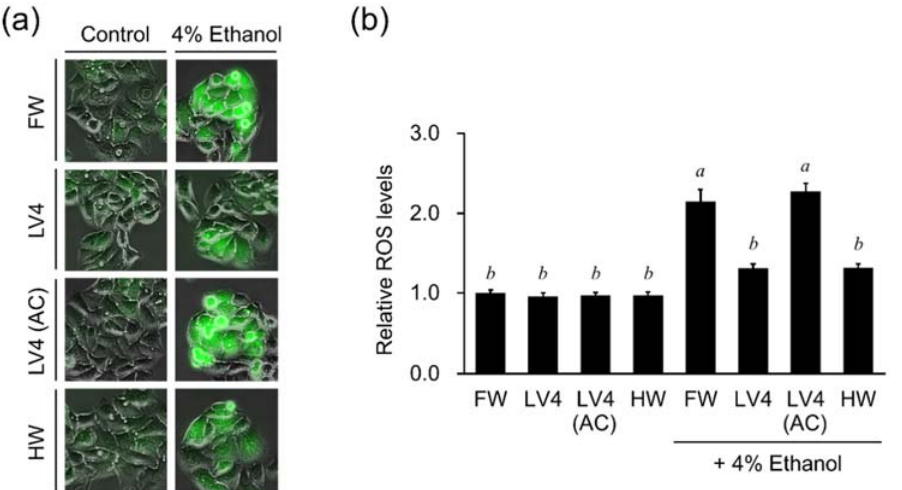
Figure 4. The effect of different water samples on the intracellular ROS levels after ethanol treatment in HepG2 cells. ( a ) Fluorescence microscopy images. ( b ) Relative ROS levels in cells. HepG2 cells were treated with 4% ethanol in medium containing filtered water (FW), untreated EHW LV4 (LV4), autoclaved EHW LV4 [LV4 (AC)], or hydrogen rich water (HW) for 6 h, and then stained with 5 µ M of CM-H 2 DCFDA for 30 min. The data represent the mean ± SEM ( n = 3). Data were analyzed by Tukey’s test after one-way ANOVA ( p < 0.05). Different letters above the bars indicate significant difference among treatments for each water with or without 4%